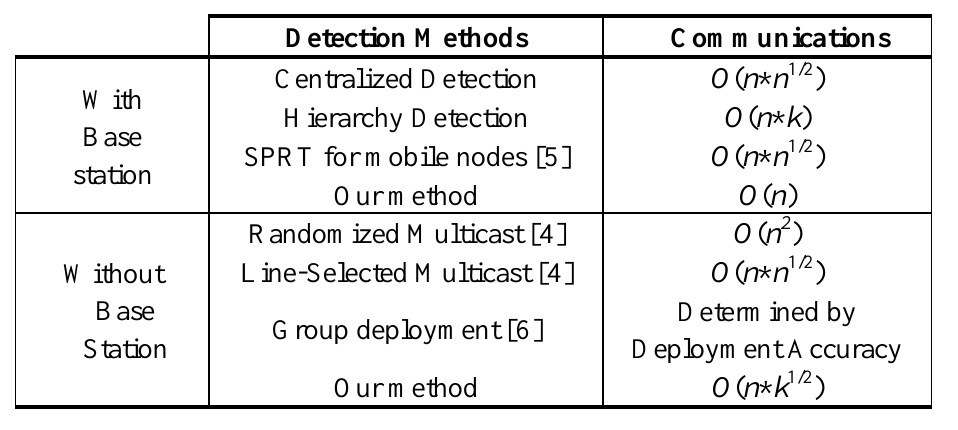
Table 2. Communication cost. Scale and align